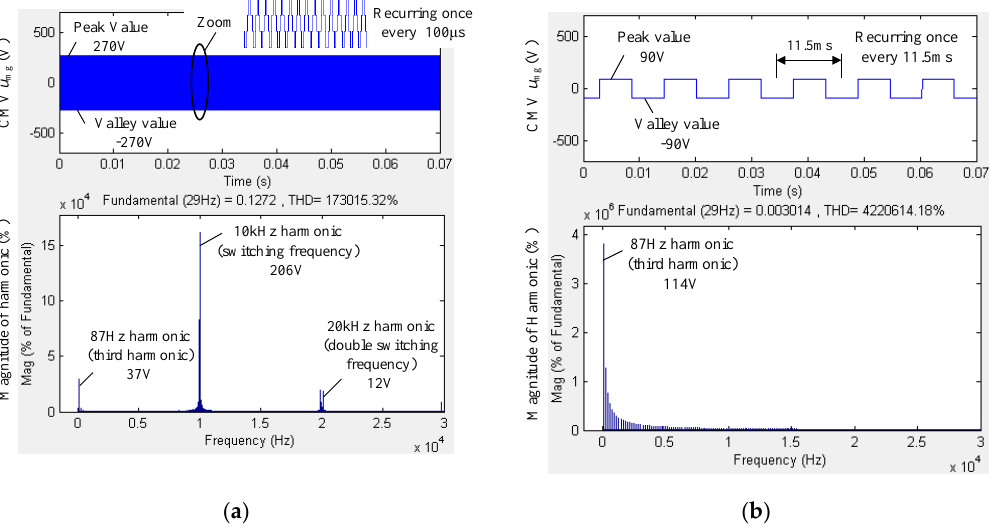
Figure 4. Common-mode voltage simulation waveforms and their FFT analysis in two methods. ( a ) Conventional SVPWM; ( b ) CMRSVPWM.